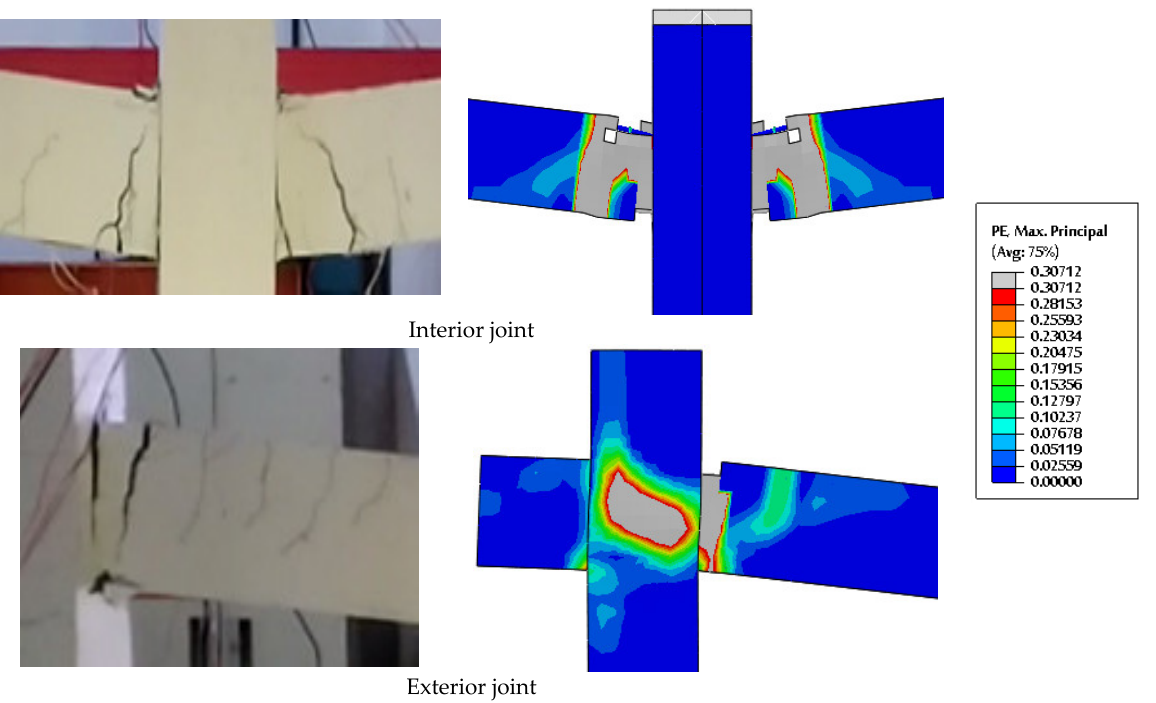
Figure 14. Comparisons of the experimental and FEM crack patterns of the RuC frame at failure.